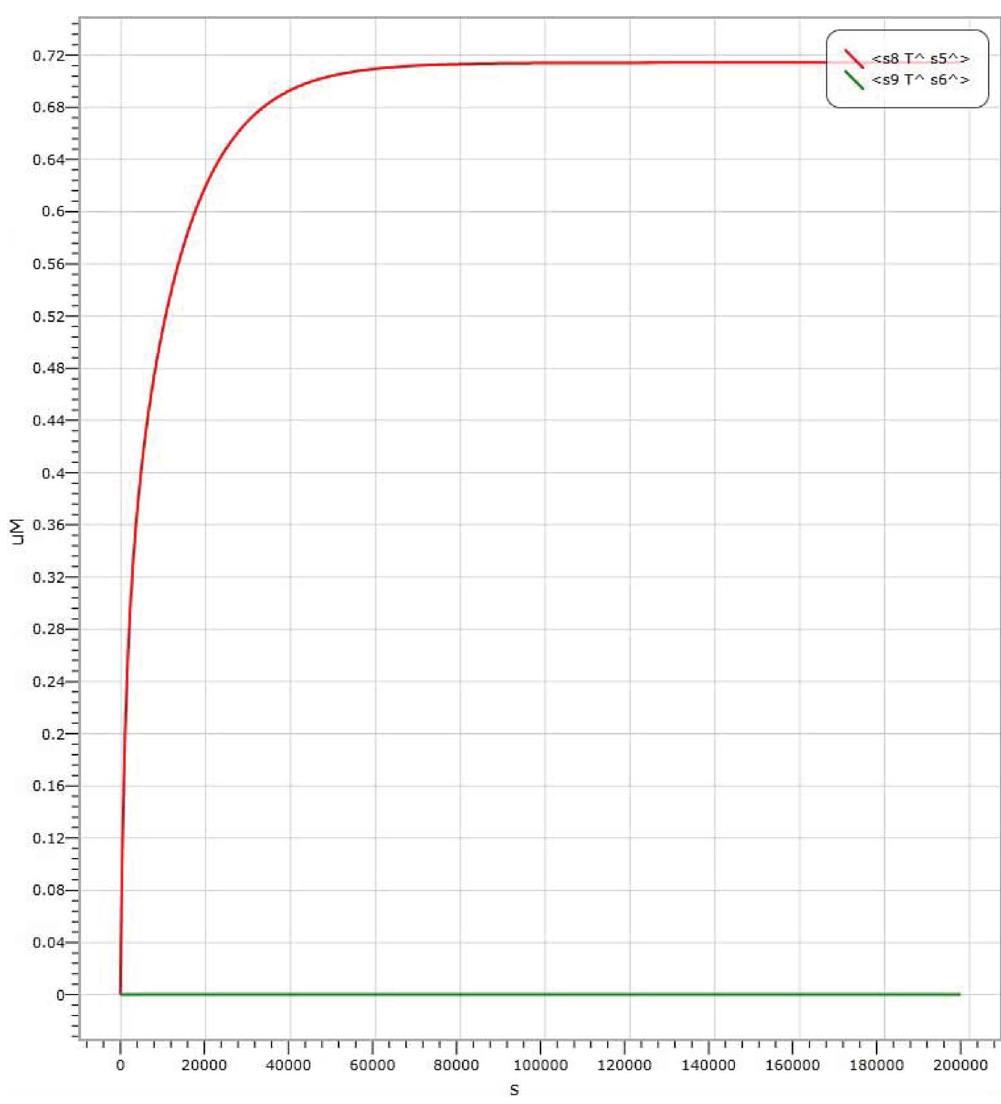
Figure 8. Visual DSD simulations of AND logic gate with input signal ‘‘11’’.